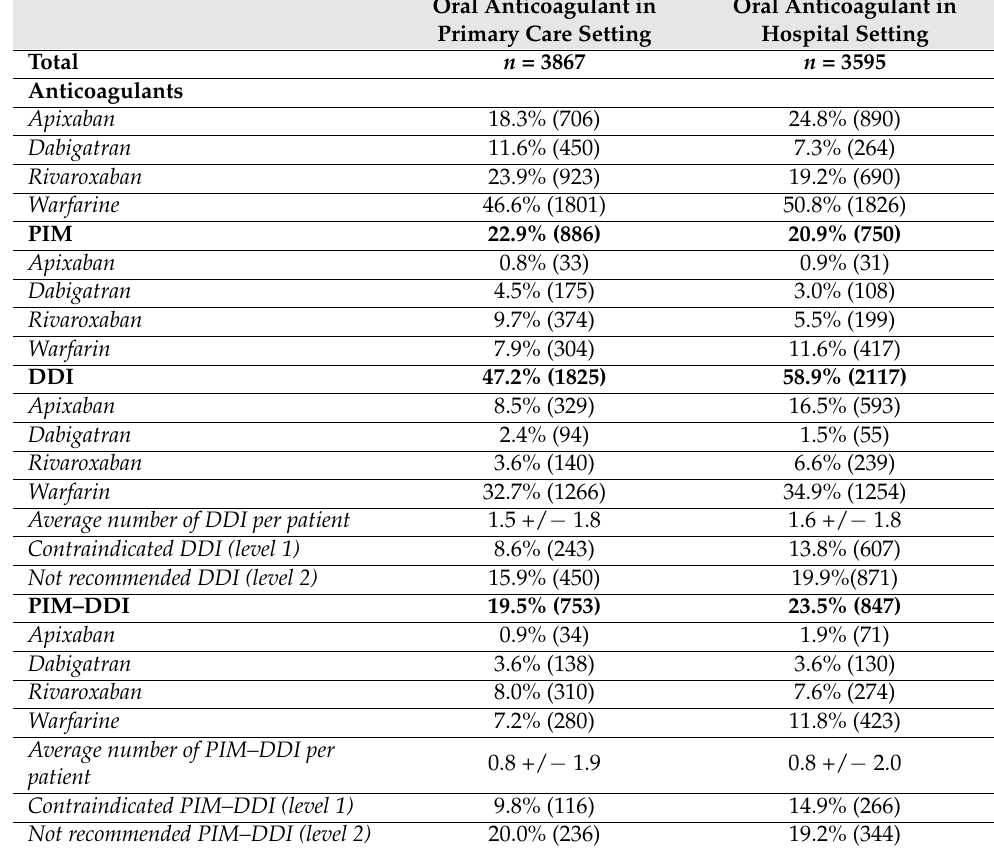
Table 2. Oral anticoagulants treatments of the hospitalized patients in both settings (primary care and hospital setting). Prevalence of DDI, PIM and PIM–DDI correspond to the ratio of patients with DDI, PIM or PIM–DDI on the total of patients ( n = 3867 in primary care and n = 3595 in hospital